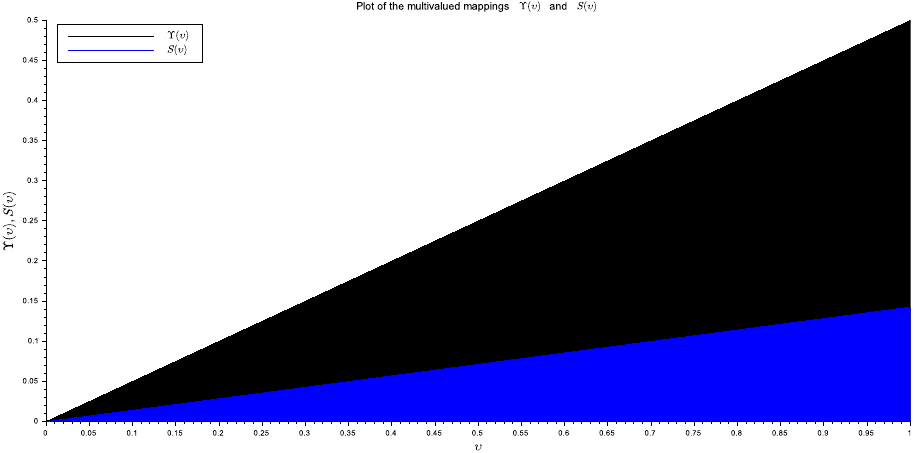
Figure 1. Combined plot of the multivalued mappings Υ and S